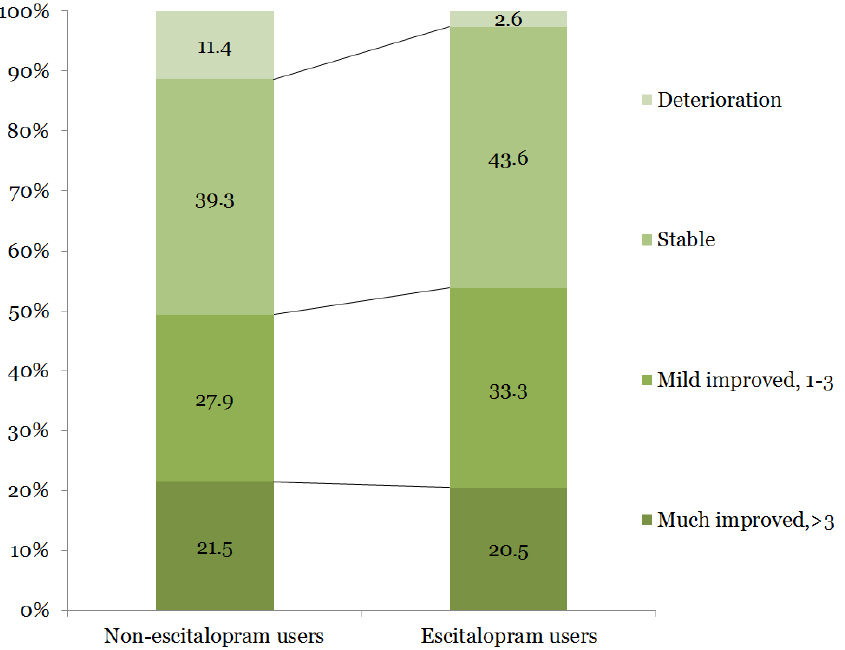
Figure 2. Four categories of changes in neurological severity. Change in NIHSS score = NIHSS score at admission—NIHSS score at discharge. Much improved: >3; mild improved: 1–3; stable: 0; and deterioration: negative value. NIHSS: National Institutes of Health Stroke Scale. Percentages may not add up to 100% due to